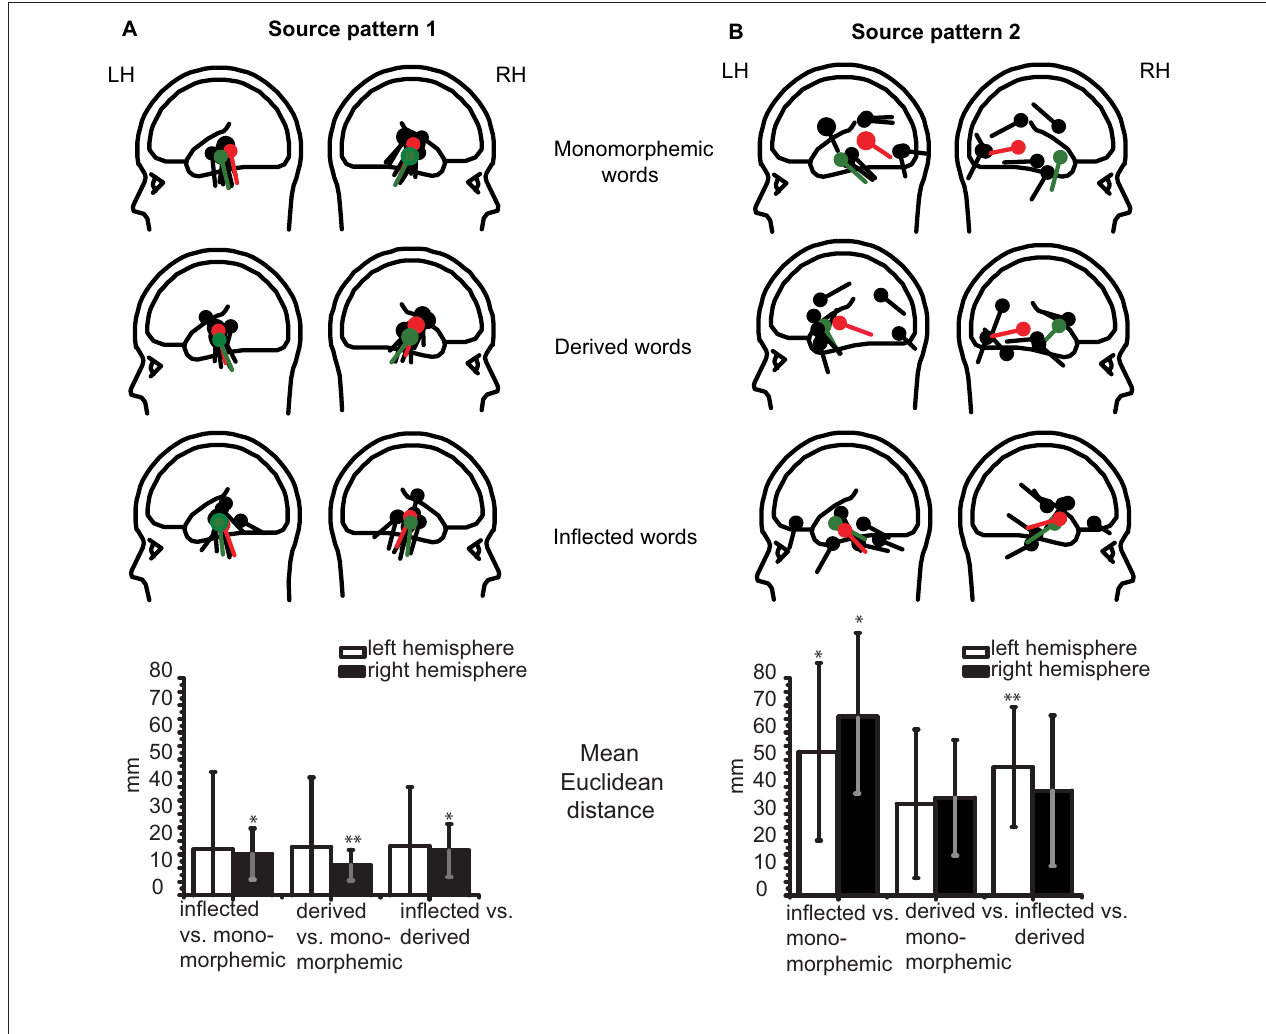
displayed as red and green dipoles, respectively. (Below) mean Euclidean distance (columns) and SD (error bars) in millimeters between conditions for Source pattern 1 (A) and Source pattern 2 (B) . Asterisks display significant differences between conditions against the baseline of 0 mm (** = p < 0.01; * = p